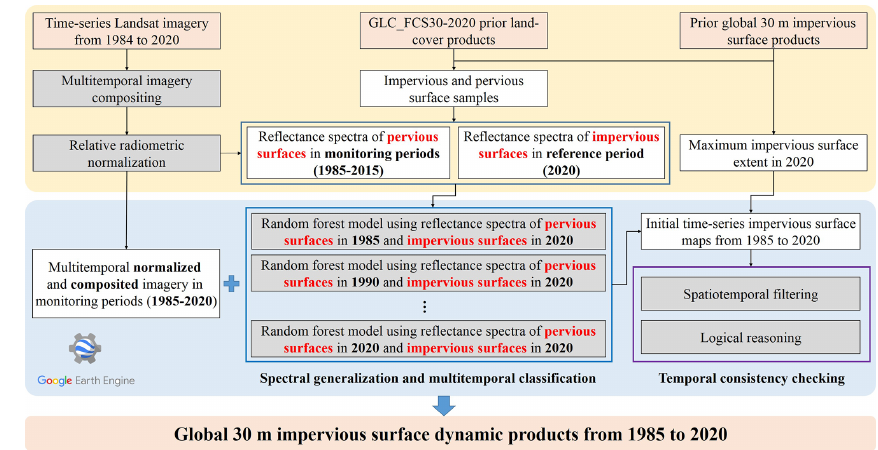
Figure 3. The flowchart of the spectral-generalization method for automatically monitoring the spatiotemporal dynamics of impervious surface from 1985 to